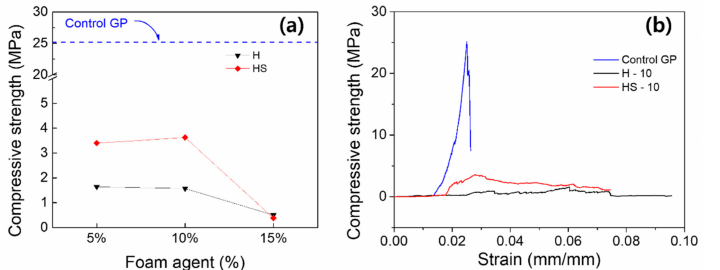
Figure 6. ( a ) The compressive strength as a function of the content of foaming agents with or without the presence of surfactant ( H and HS ), and ( b ) as shown below, stress–strain curve for Control GP, H -10, HS